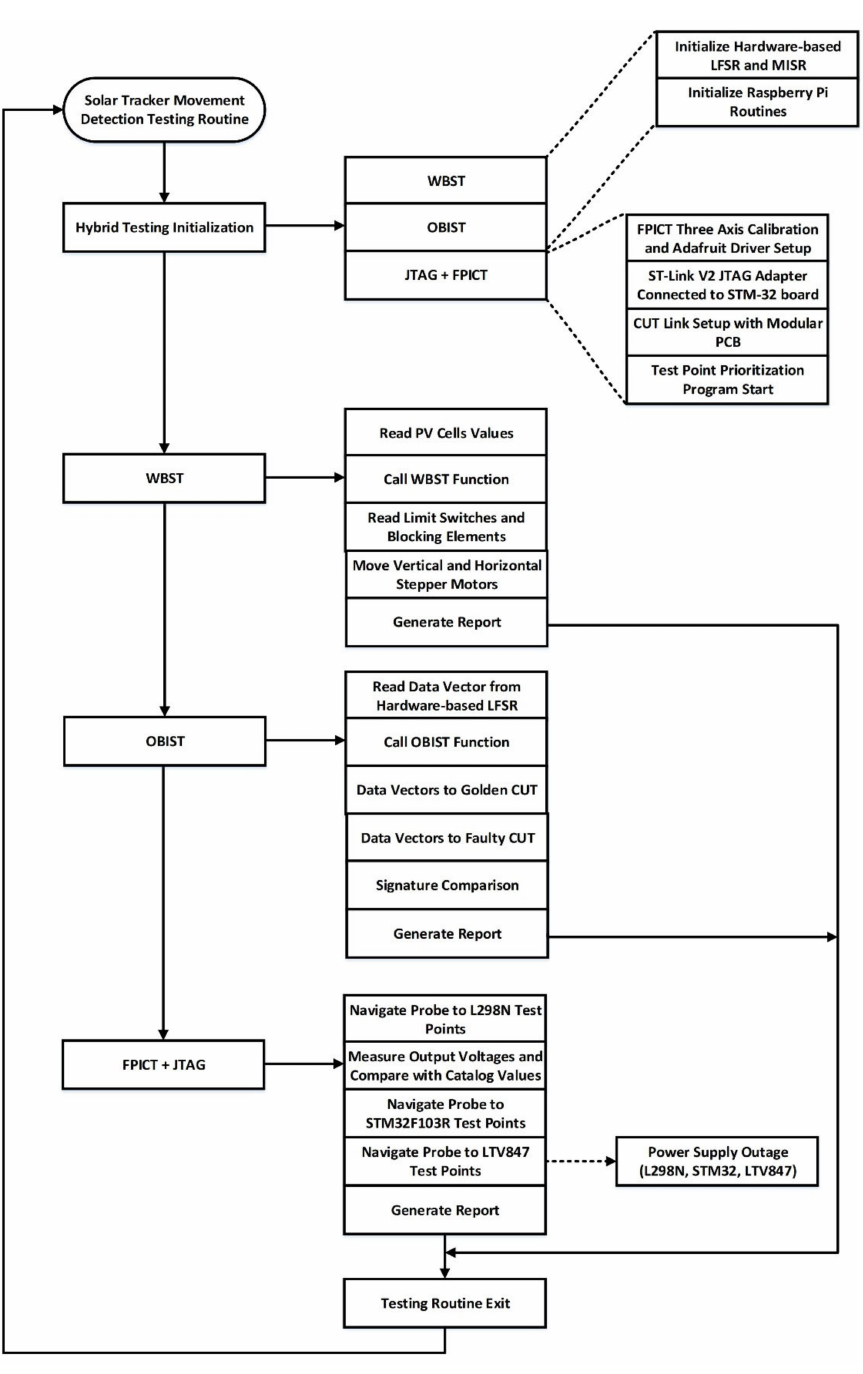
Figure 5. Automated scheduling diagram for the proposed combined testing